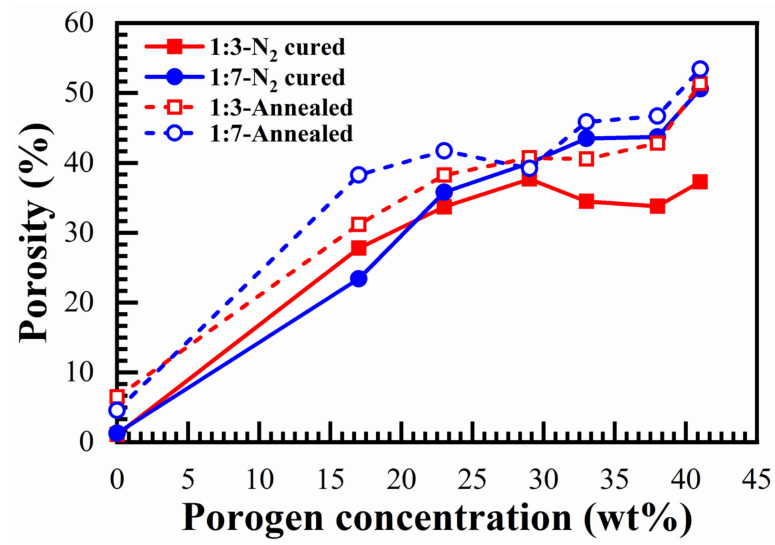
Figure 21. Effect of annealing at 600 ◦ C for 30 min (annealed) on the porosity of 1:3- and 1:7-benzene bridge ratio N 2 -cured at 400 ◦ C for 60 min (N 2 -cured) samples with different porogen (0 to 41 wt%) loadings. The porosity of both N 2 annealing samples is calculated by using the Lorentz–Lorenz equation.